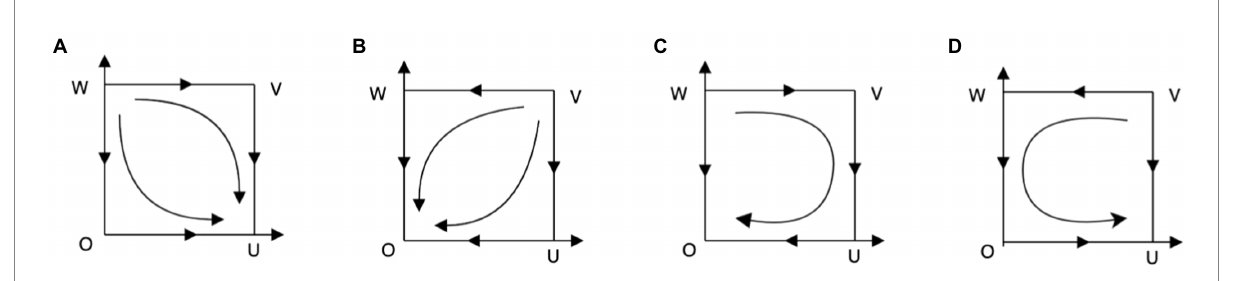
FIGURE 2 Phase diagram of system evolution when (